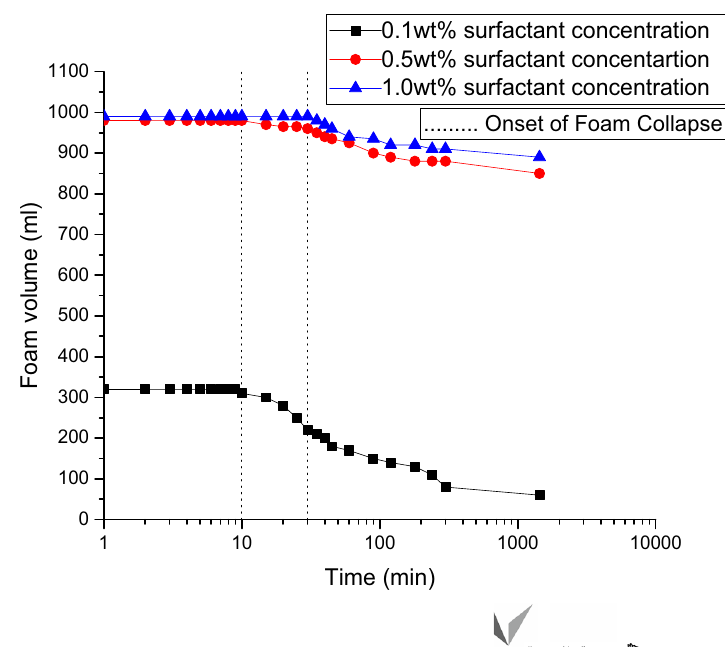
Fig. 7 Determination of